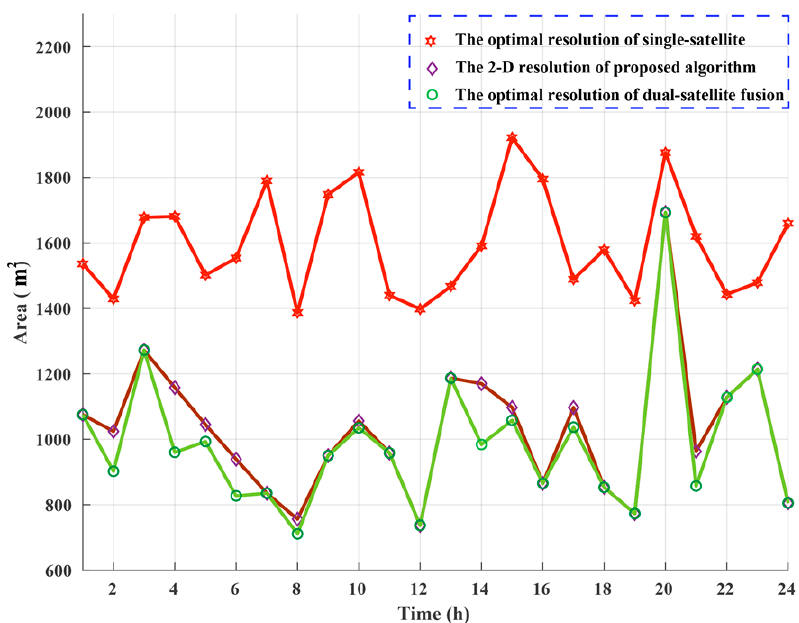
Figure 10. Distribution of the area of the resolution units in 24 h.